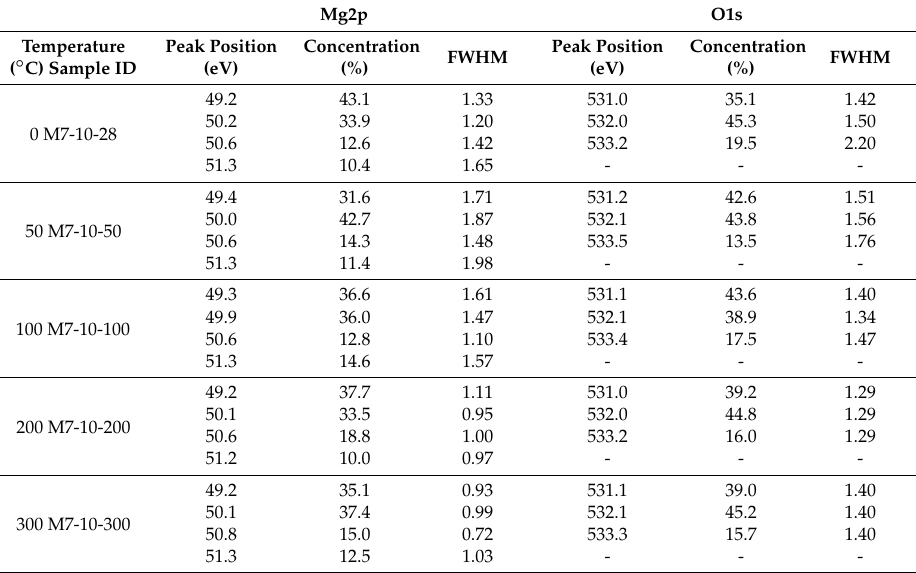
Figure 4. Percentage of different oxygen components for samples subjected to different temperatures. Table 4. Peak information for Mg2p and O1s at different temperatures.